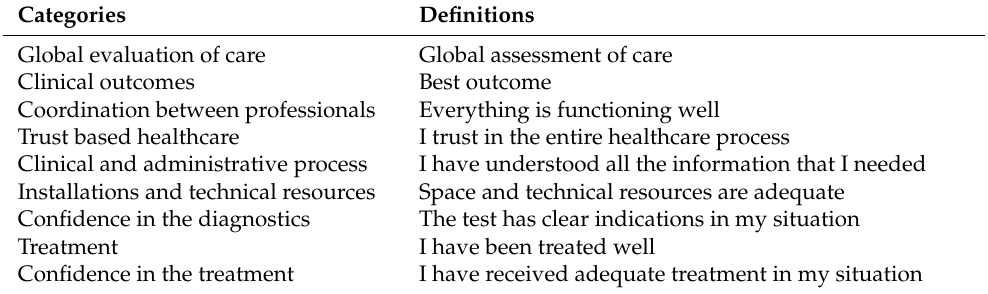
Table 1. Evaluation of health quality categories in the questionnaires used for patients and profes-